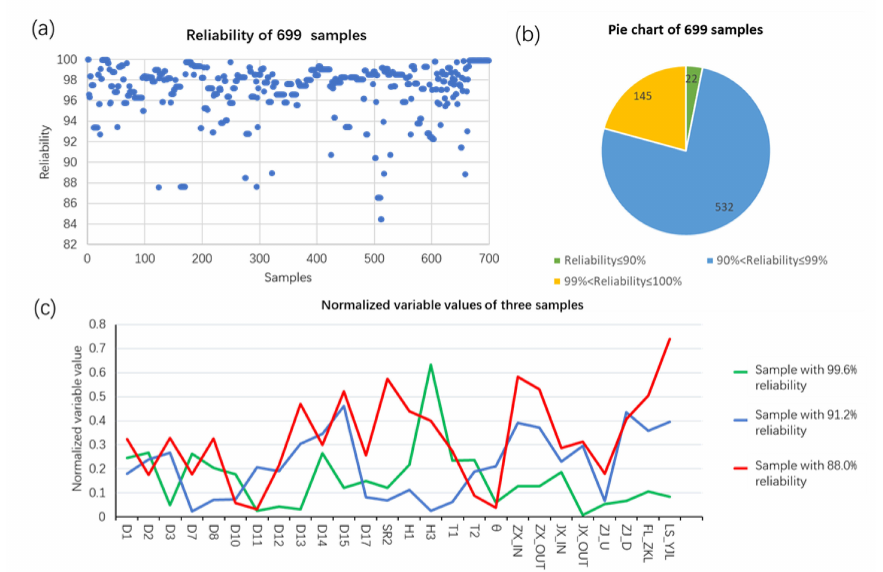
Figure 5. ( a ) Reliability scatter diagram of 699 samples. ( b ) Pie chart of reliability of 699 samples. ( c ) The normalized variable values of three typical samples with different